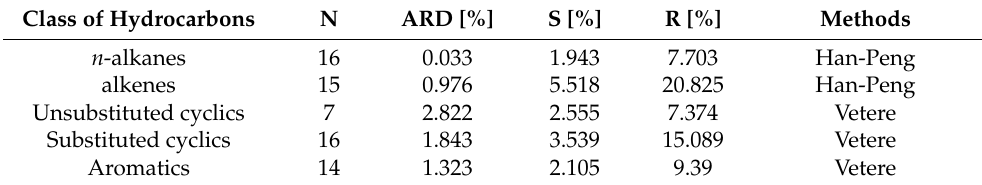
Table 9. Selected methods to predict the acentric factor ( ω ) of hydrocarbons classes ( n -alkanes, alkenes, unsubstituted cyclics, substituted cyclics, and aromatics), of all the compounds present in OLP, obtained by thermal catalytic cracking of palm oil at 450 ◦ C, 1.0 atmosphere, with 10% (wt.) Na 2 CO 3